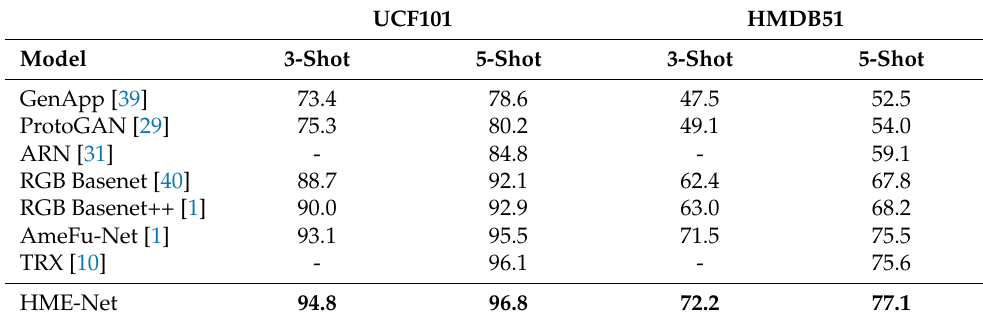
Table 1. Comparison of our method and current state-of-the-art works on UCF101 and HMDB51. We show the classification accuracy (%) in 5-way 3-shot and 5-way 5-shot video recognition. The classification results of 10,000 episodes are averaged as the final result in the Test